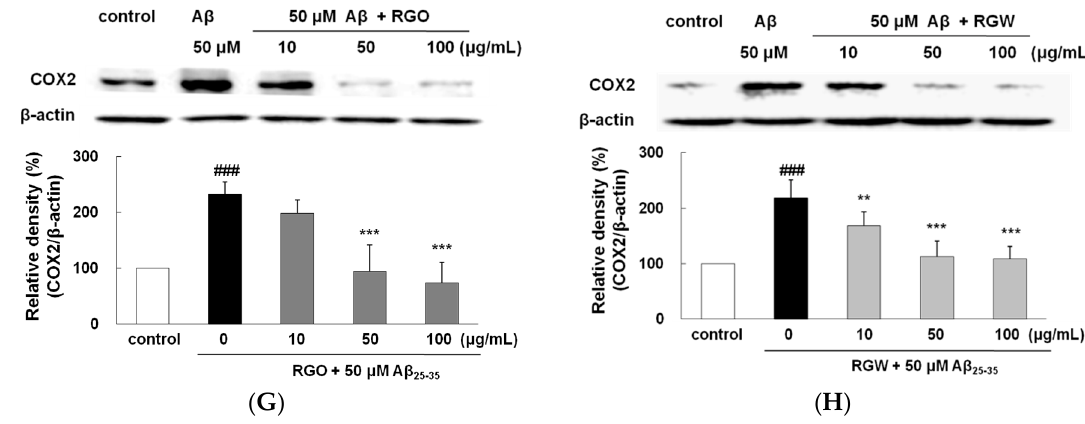
Figure 6. RGO ( A ) and RGW ( B ) protected A β 25–35 -stimulated TNF- α production. PC12 cells were treated with A β 25–35 for 30 h and then cellular lysates were analyzed by Western blot assay. Cells were pretreated with RGO or RGW for 1 h, then stimulated with 50 μ M A β 25–35 . The culture medium samples were collected 24 h later for NO and PGE 2 assay. Effect of RGO and RGW on production of NO ( C ) and PGE 2 ( D ). Effect of RGO on expression of iNOS ( E ) and COX-2 ( G ). Effect of RGW on expression of iNOS ( F ) and COX-2 ( H ). PC12 cells were treated with A β 25–35 for 30 h and then cellular lysates were analyzed by Western blot assay. The separated proteins were analyzed by Western blot, Griess and ELISA assay as described in Materials and Methods. ### p < 0.001 compared to control group; *** p < 0.001 and ** p < 0.01 compared to A β 25–35 alone (ANOVA followed by Duncan’s multiple comparison test).